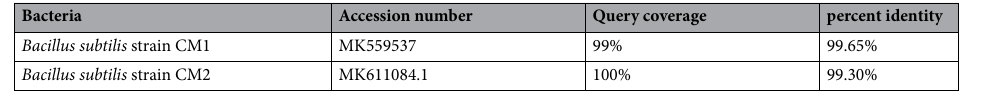
Table 2. Accession numbers and similarity of Bacillus species isolated from camel milk.